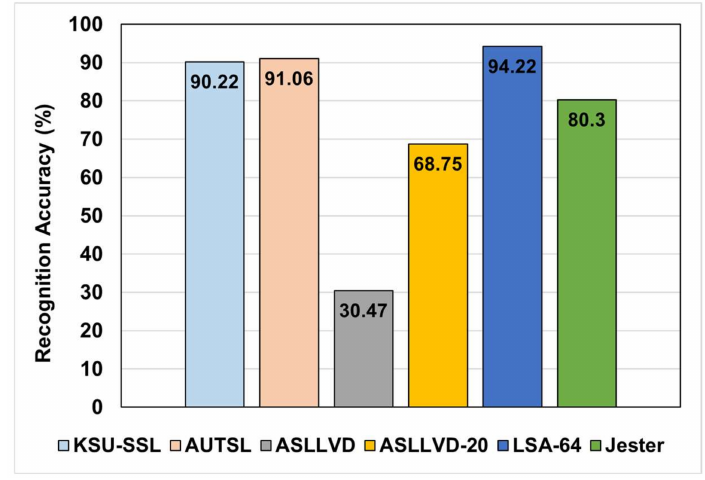
Figure 6. Basic architecture accuracy on different datasets.